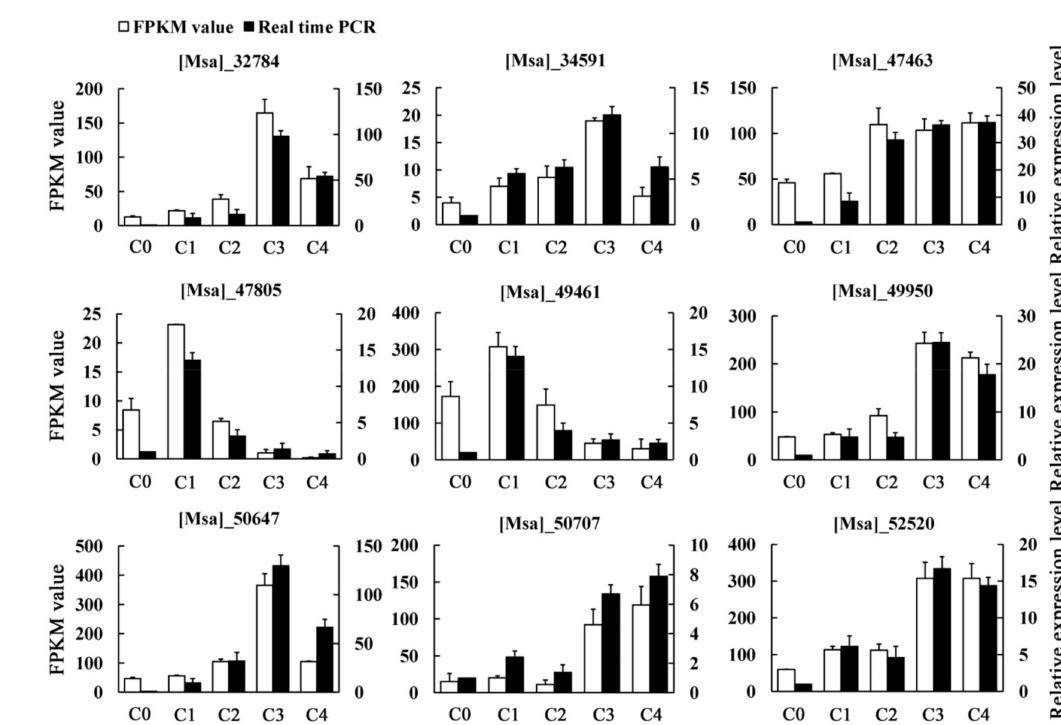
Figure 2. The expression patterns of nine randomly selected genes, identified by RNA-Seq, were validated by qRT-PCR. White bars indicate the transcript abundance change based on the Fragments Per Kilobase per Million Fragments mapped (FPKM) values of the RNA-Seq analysis (left y-axis). Black bars represent the relative expression levels determined by qRT-PCR (right y-axis). Error bars indicate standard errors of the means ( n =